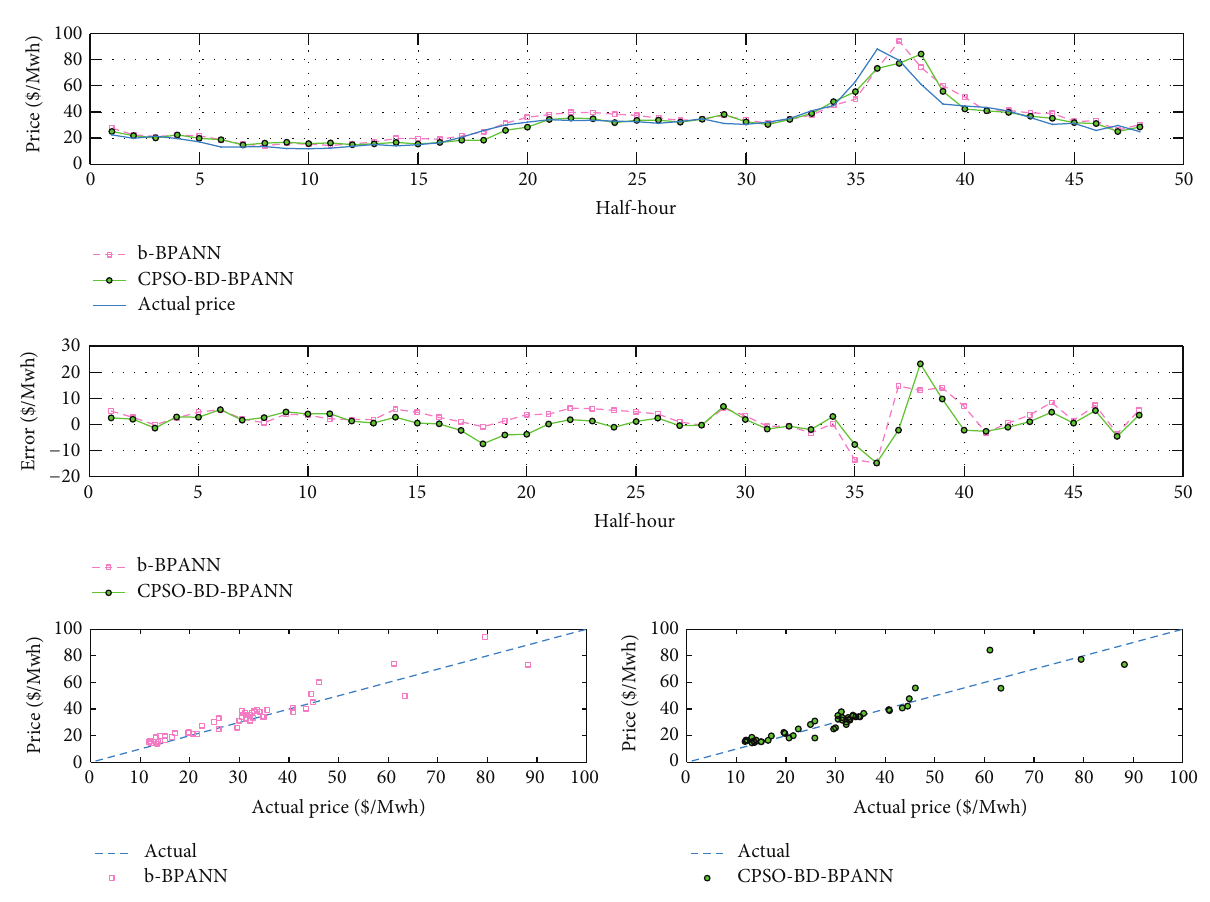
Figure 8: BPANN and CPSO-BD-BPANN methods for case